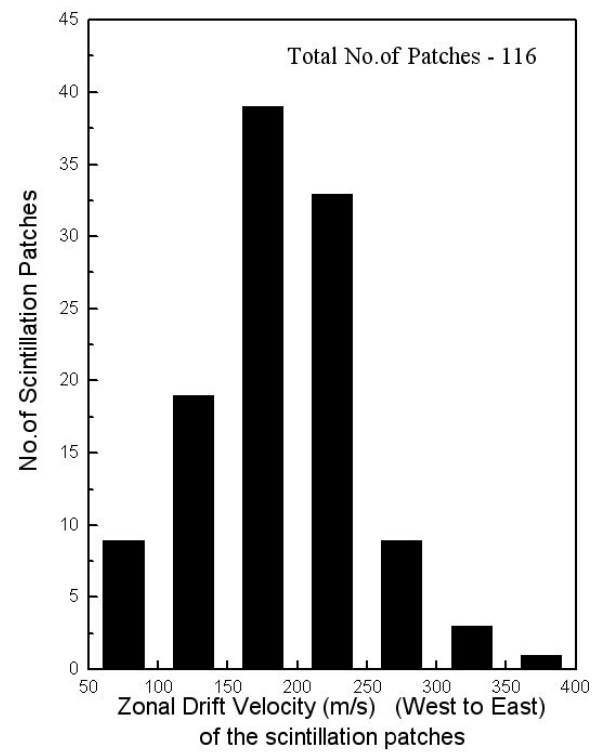
Fig. 4. Histogram showing the distribution of zonal (west to east) drift velocities of PBI irregularities.